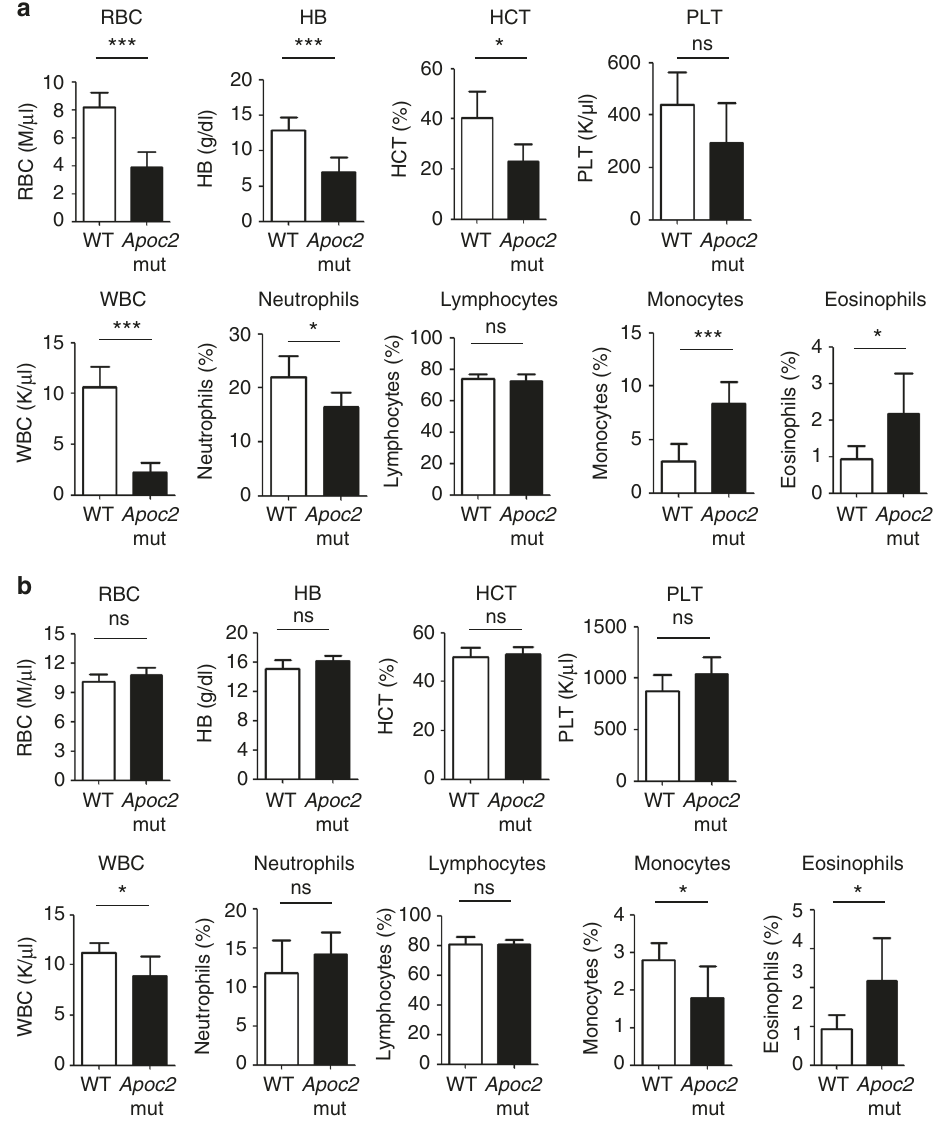
Fig. 9 Complete blood count in WT and Apoc2 mutant mice. a Blood samples from WT mice and Apoc2 mutant mice were analyzed at the time of weaning (28 – 31 days old). WT, n = 7 (four males and three females); Apoc2 mutants, n = 5 (two males and three females). No apparent differences between sexes were observed in each group. b Blood samples from WT mice and Apoc2 mutant mice were analyzed at the age of 4 – 5 months. n = 5 in each group, all males. Results are mean ± SEM; * P < 0.05 and *** P < 0.001 (Student ’ s t test). WBC white blood cells, RBC red blood cells, HB hemoglobin, HCT hematocrit, PLT platelets. Absolute numbers of WBC and percentages (%) of neutrophils, lymphocytes, monocytes and eosinophils are shown in lower row of graphs in a and